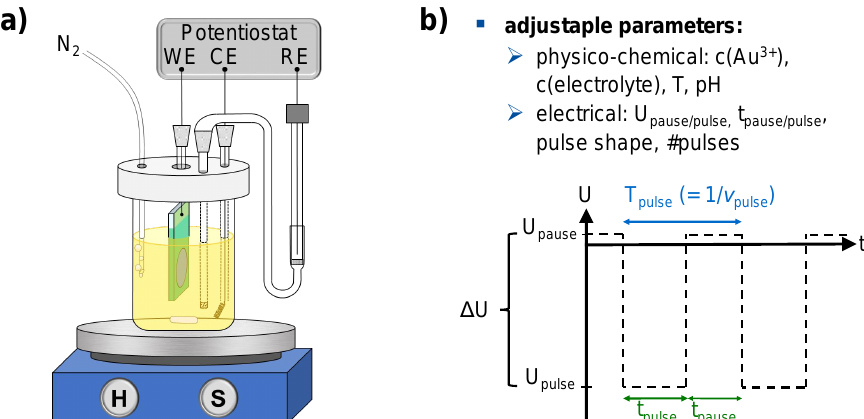
Figure 2. Pulsed electrodeposition of Au-NPs into MTTFs. ( a ) schematic representation of the used setup and ( b ) adjustable